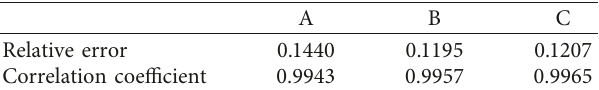
Table 5: The relative error and the correlation coefficient of the identified impacts.